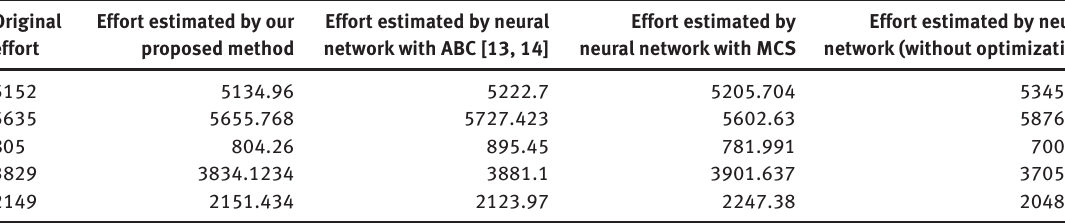
Table 4: Analysis of the Estimated Effort for the Desharnais Dataset.